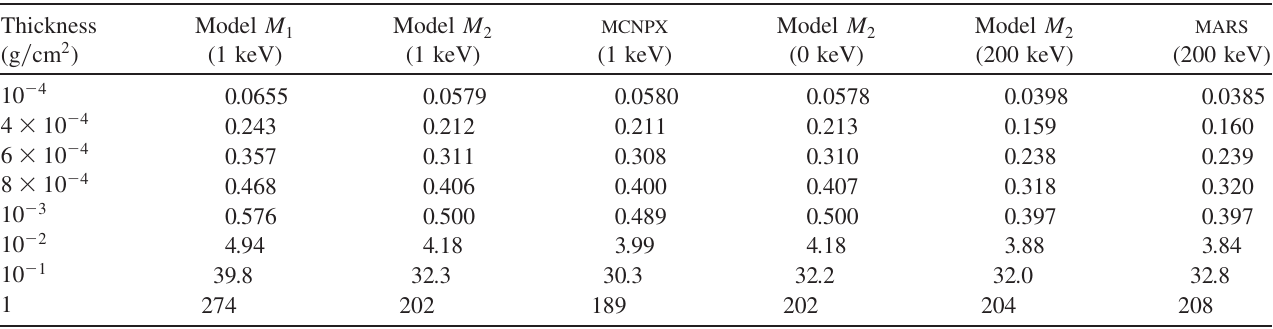
TABLE III. Energy (keV) taken away by generated (cid:1) electrons that escape the carbon foil of a given thickness. Normalization is per incident 8-GeV proton. The electron energy cutoff used in the calculations is shown in parentheses. Thickness